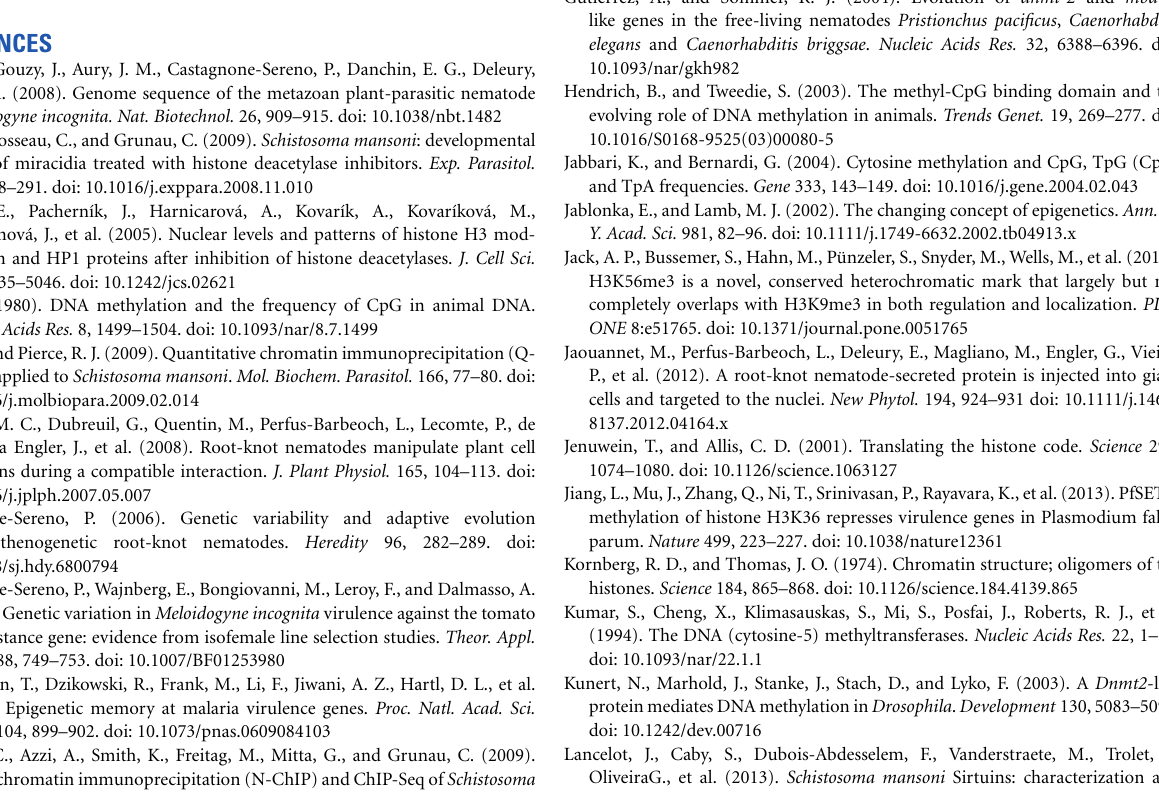
M. incognita J2s. (A) Anti-H3K4Me3 or Anti-H3K9Me3 antibodies. (B) Anti-H4PentaAc antibody. (C) Anti-H3K27Me3 or Anti-H3K36Me2 antibodies. Supplementary Figure 3 | Electrophoresis gel of M. incognita eggs DNA after 0, 2, 4, 5, 6, and 7min MNase (30U). Marker 1 and 2 exhibit regularly spaced bands ranging from 200 to 10,000bp and 100 to 1000bp,